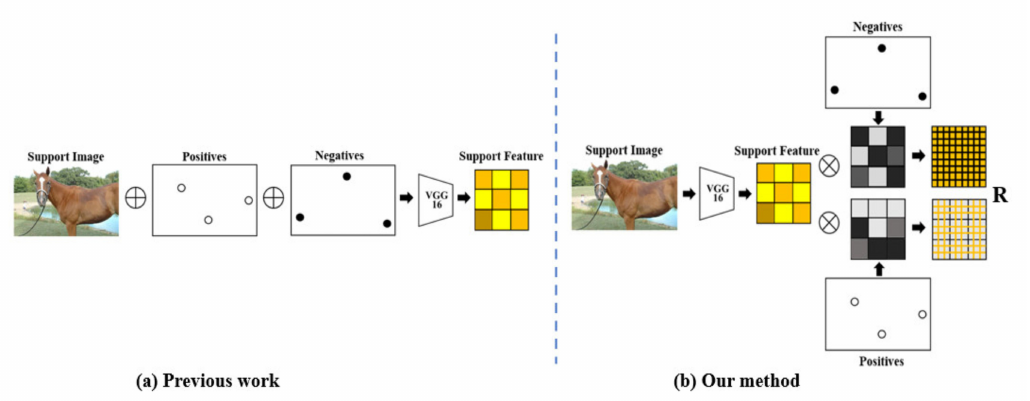
Figure 3. Extracting a task representation from the support. ( a ) Previous work simply stack the support and annotations channel-wise. ( b ) Our method factorizes into image and annotations streams and improves learning e ffi ciency and inference accuracy.